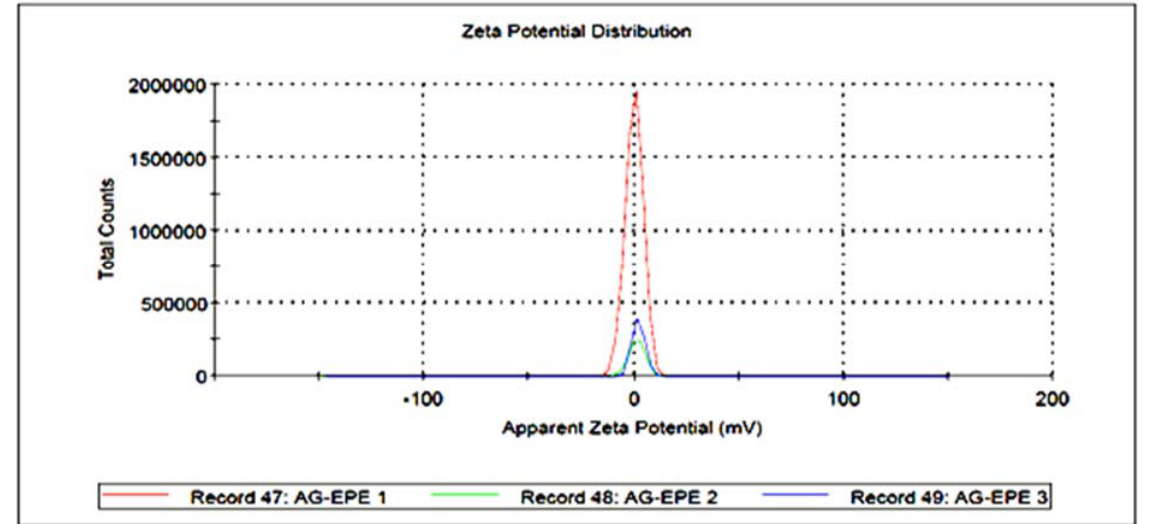
Figure 3. Size and charge of silver nanoparticles prepared using ethanolic (AgEPE) extract as measured by zeta sizers. Table 3. Size distribution and zeta potential of AgNPs prepared using aqueous (WPE) or ethanolic (EPE) extracts.